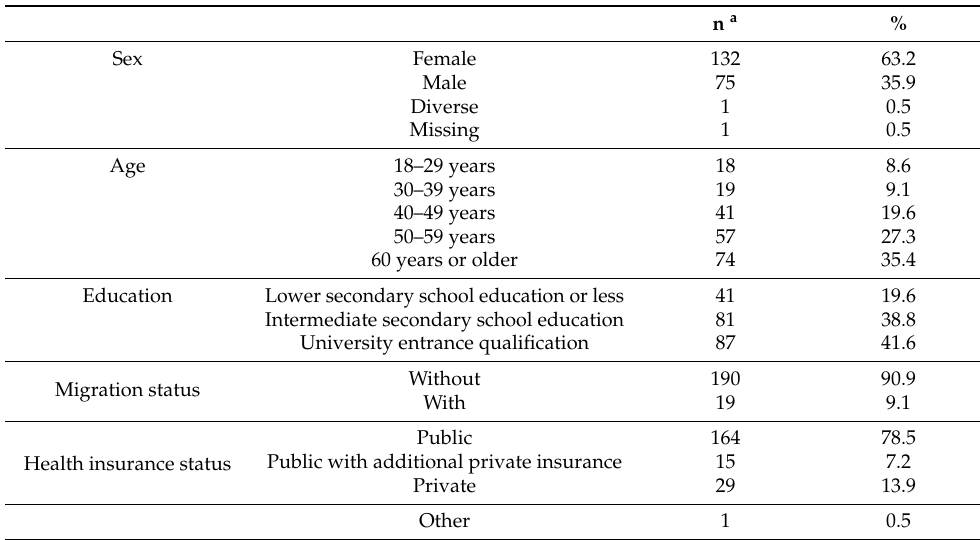
Table 2. Sociodemographic characteristics of the sample (n =